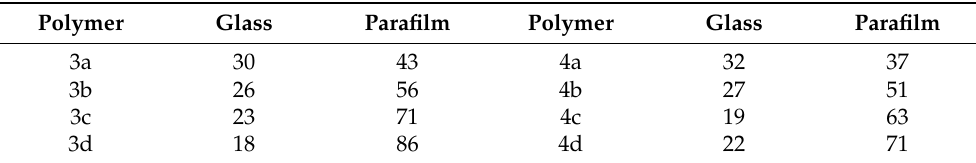
Table 3. The contact angle values of silatrane-containing polymer solutions on different substrates. ( θ , grad).